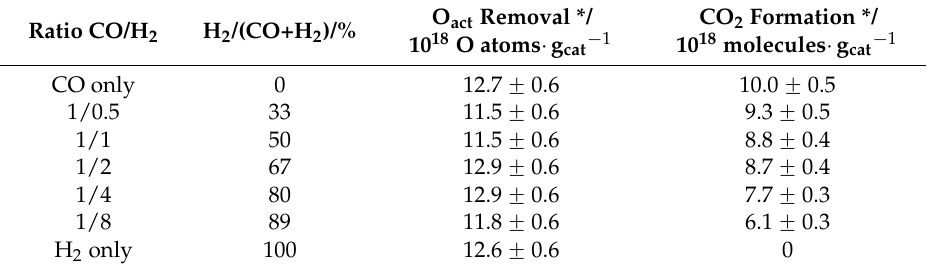
Table 2. Absolute amounts of active stable oxygen (O act ) removal and CO 2 formation during CO, H 2 , and CO/H 2 pulses with different CO/H 2 ratios on the fully oxidized Au/TiO 2 catalyst at 400 ˝